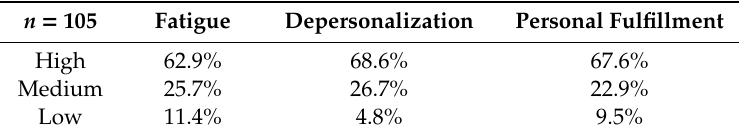
Table 2. Distribution of burnout in the sample.